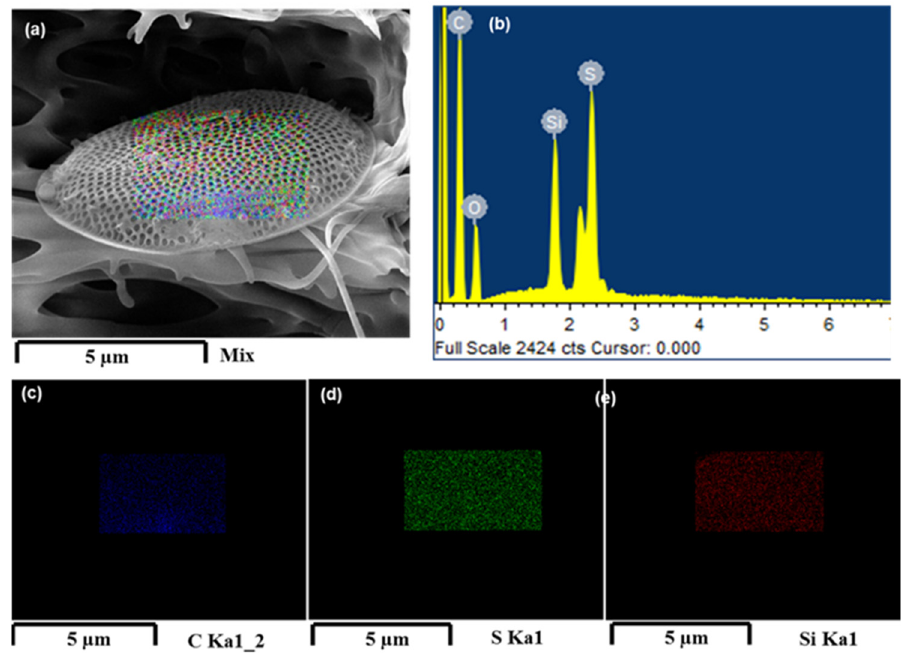
Figure 10. SEM-EDX imaging and mapping of silica frustules embedded in PSF/Dia 0.5 membrane. ( a ) Cross-sectional image, ( b ) EDX spectrum, and ( c – e ) elemental mapping on silica frustules: ( c ) carbon, ( d ) sulfur, and ( e ) silicon.